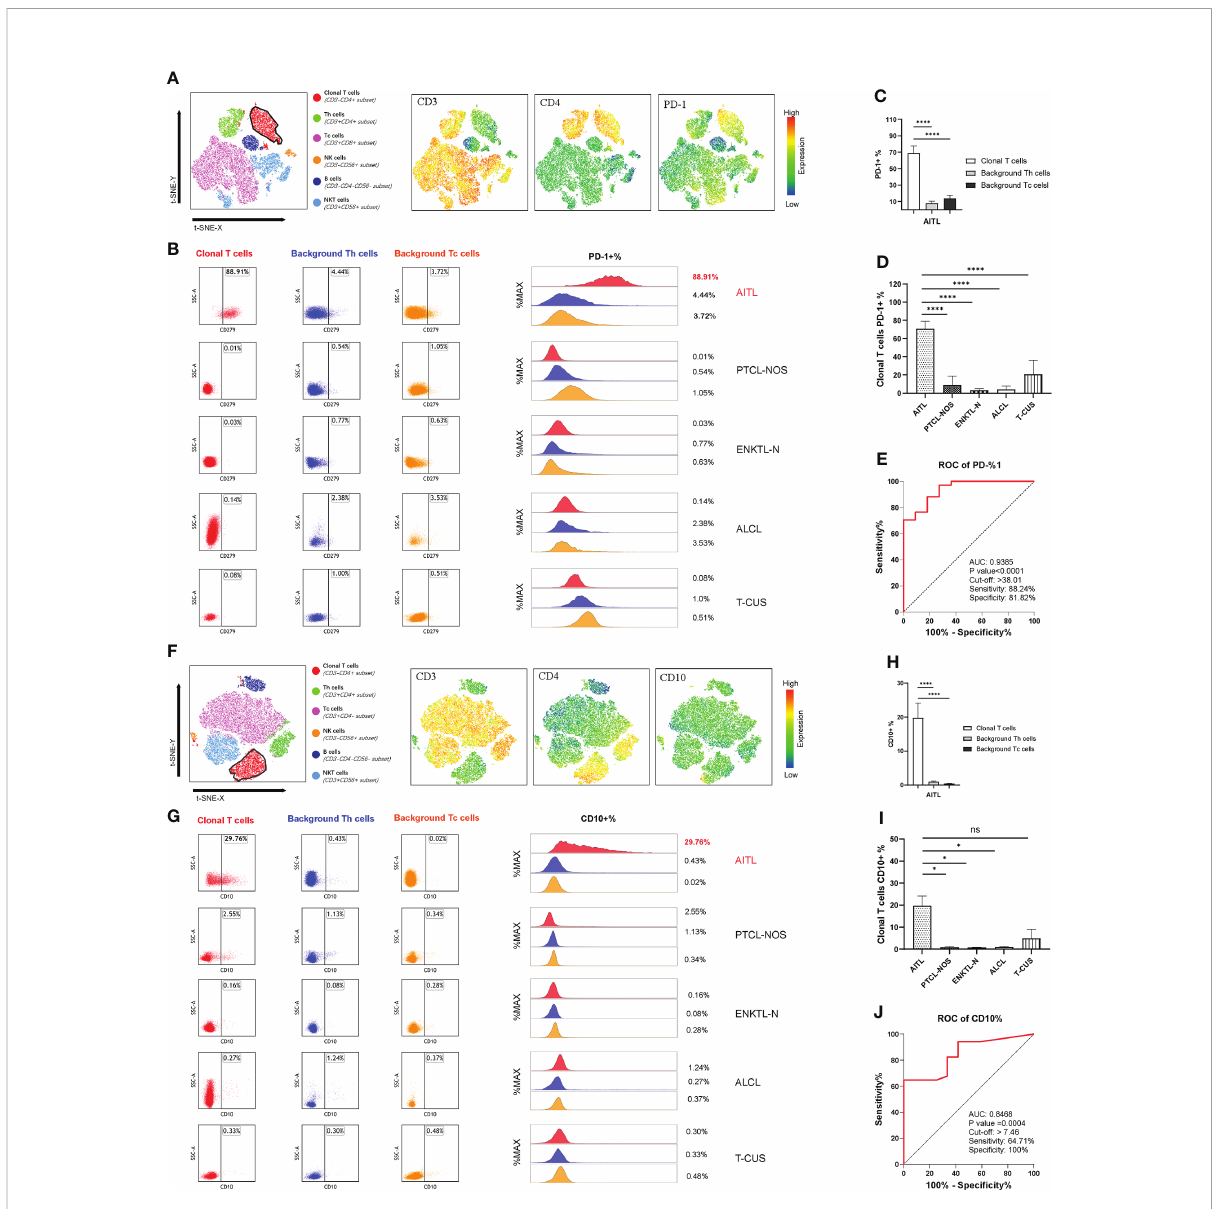
FIGURE 5 PD-1 and CD10 speci fi city patterns of AITL. (A) t-SNE map of AITL patients showing the expression pattern of CD3-CD4+PD-1+. Different colors represent different cell clusters. The positions of the red clusters are clonal T cells of AITL. (B) PD-1 expression in AITL, PTCL-NOS, ENKTL-N, ALCL and T-CUS cloned T cells and background normal Th and Tc cells. (C) Histogram of mean PD-1 expression rates in clonal T cells and background normal Th and Tc cells in patients with AITL. (D) Histograms of mean PD-1 expression rates on clonal T cells in patients with AITL, PTCL-NOS, ENKTL-N, ALCL, and T-CUS. (E) Receiver operating characteristic (ROC) curves evaluating PD-1-de fi ned AITL. (F) t-SNE plot of AITL patients showing the expression pattern of CD3-CD4+CD10+. Different colors represent different cell clusters. The positions of the red clusters are clonal T cells of AITL. (G) CD10 expression of AITL, PTCL-NOS, ENKTL-N, ALCL and T-CUS cloned T cells and background normal Th and Tc cells. (H) Histogram of the average expression rate of CD10 in clonal T cells and background normal Th and Tc cells in patients with AITL. (I) Histogram of mean CD10 expression rates in clonal T cells in patients with AITL, PTCL-NOS, ENKTL-N, ALCL and T-CUS. (J) Receiver operating characteristic (ROC) curves evaluating CD10-de fi ned AITL. (*p < 0.05, ****p <